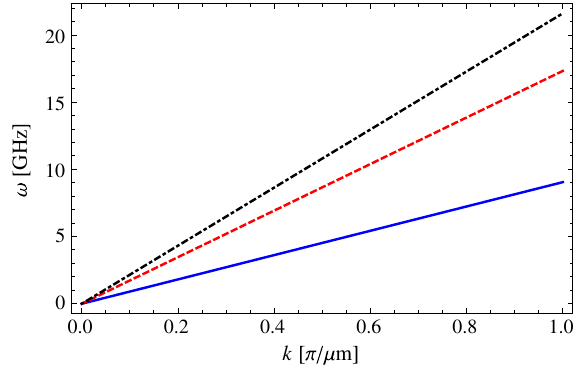
v k of the three ð n ¼ 1 ; 2 ; 3 Þ n ¼ n